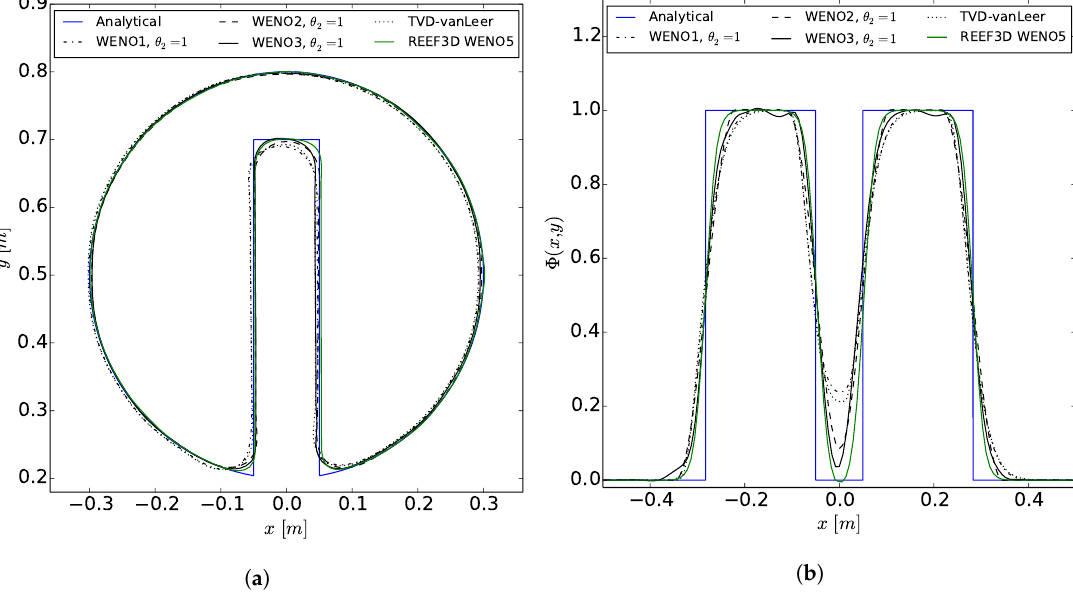
256 squares. ( a ) Contour plot of ×